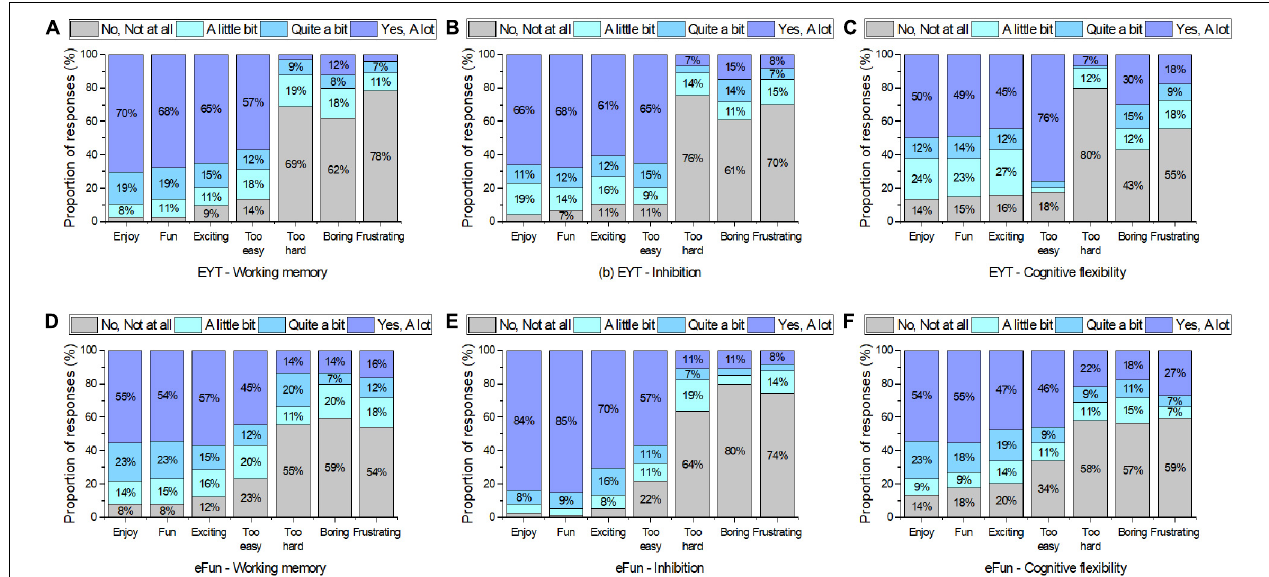
FIGURE 5 | Student experience ratings for (A) EYT – Working memory, (B) EYT – Inhibition, (C) EYT – Cognitive flexibility, (D) eFun – Working memory, (E) eFun – Inhibition, and (F) eFun – Cognitive